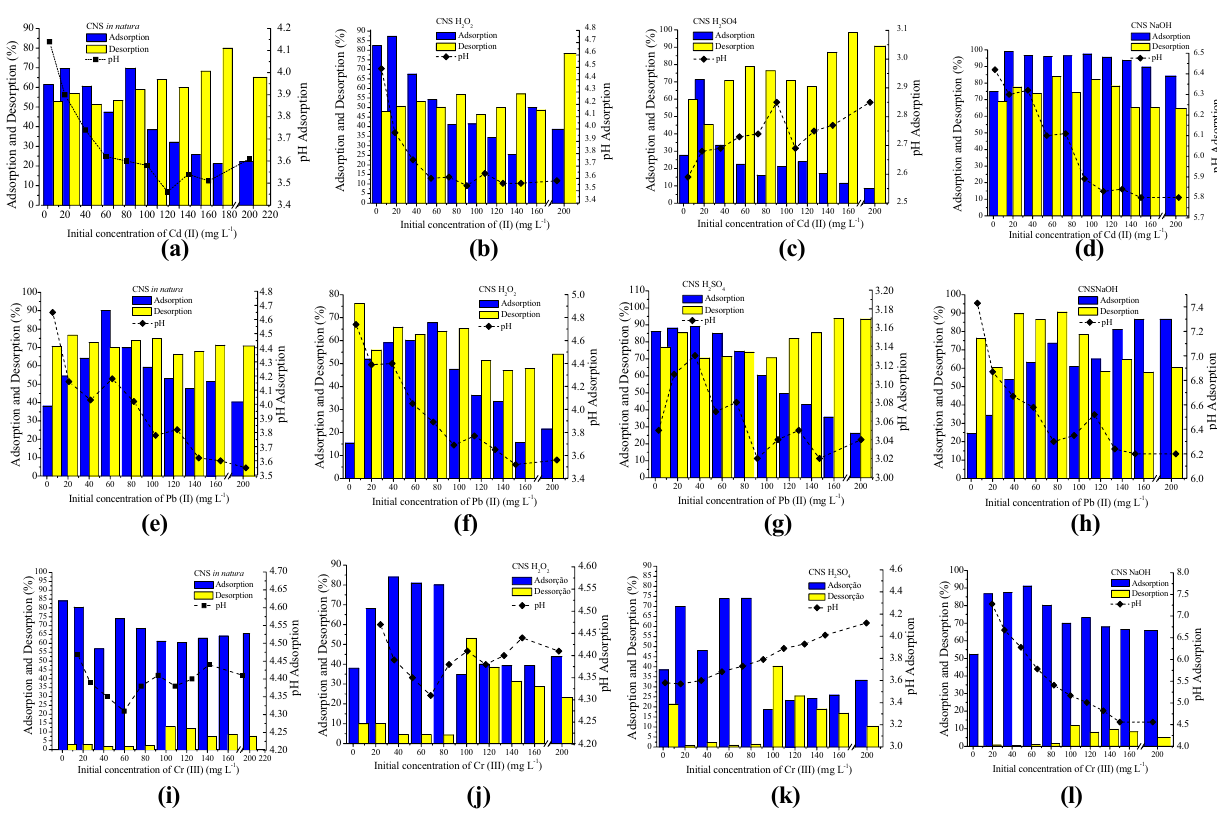
Fig. 10 Adsorption (%), desorption (%) and pH after adsorption of Cd 2+ ( a – d ), Pb 2+ ( e – h ) and Cr 3+ ( i – l ), respectively, by CNS in natura and modified with H 2 O 2 , H 2 SO 4 and